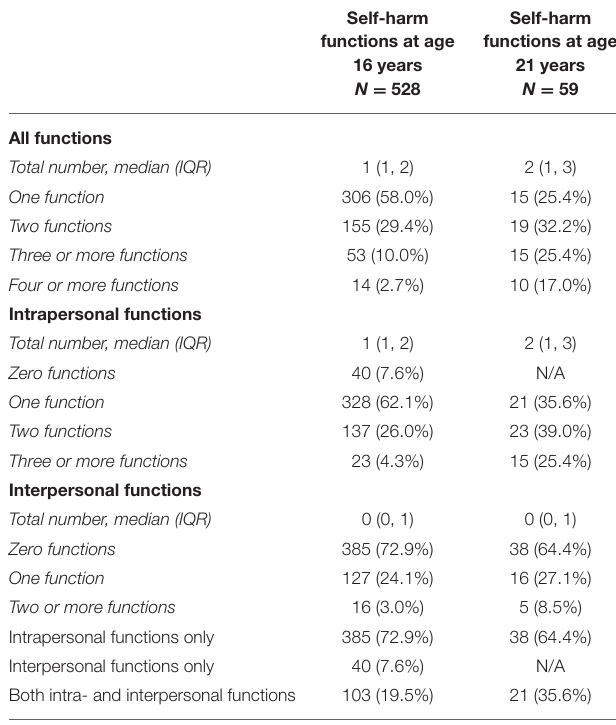
TABLE 1 | Comparison of self-harm functions at 16 and 21 years: complete case data.